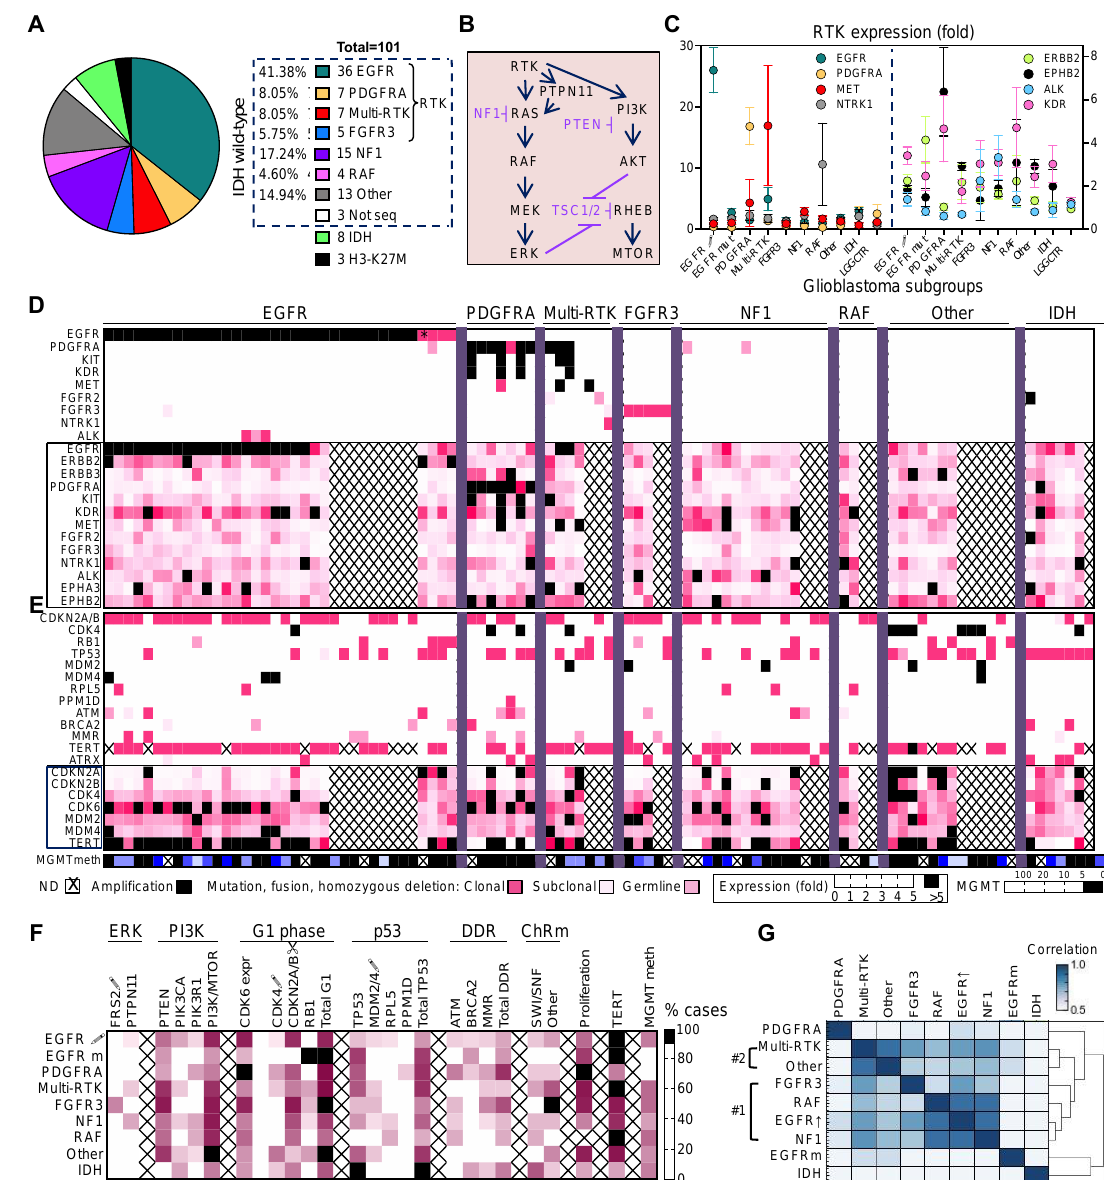
Figure 1. Glioblastoma molecular subgroups—molecular characteristics and pathway-based clustering. ( A ) Subgrouping of the glioblastoma cohort in non-overlapping molecular alterations corresponding to ERK/MAPK signaling pathway. ( B ) Diagram of the canonical ERK/MAPK and PI3K signaling pathways. Inhibitors are indicated in purple; arrows and blunt arrows represent activation or inhibition, respectively. ( C ) RTK fold-expression in glioblastoma subgroups, as mean ± SEM values, showing RTKs with high or intermediate overexpression on the left or right y -axis, respectively. EGFR ↑ , EGFR with gene amplification; EGFRm, EGFR with mutation only; LGG CTR, low-grade glioma expression control subgroup. ( D , E ) Heatmaps of subgrouped individual tumors showing mutation – expression correlations for RTKs ( D ) and cell cycle G1 phase, p53, DDR and telomere elongation pathways ( E ). Colored or black squares mark presence of genomic alterations in the upper part of the heatmaps. Asterisk (*) marks the multifocal EGFR#33 case with EGFR amplification in the main focus and EGFR mutation in the secondary focus, for which the expression profile is shown. Genes boxed in pink show expression data. MGMT promoter methylation (meth) is also shown, with positive values ≥ 5. ND, not determined. ( F ) Heatmap of % cases with indicated alterations grouped in pathways, based on the values from Table 1 for the glioblastoma subgroups. ↑ , gene amplification (CN ≥ 7); ↓ , homozygous loss; ChRm, chromatin remodeling. The gene composition of the DDR and ChRm pathways is described in Table 1. Mean CDK6 and proliferation markers expression values are also included. ( G ) Hierarchical clustering of glioblastoma subgroups by multivariable Pearson correlation analysis. Note two subgroup clusters #1 and #2, and individual segregation of the PDGFRA, EGFRm and IDH